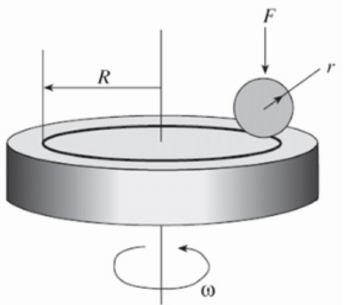
Figure 2. Tribological tests of samples according to the “ball-and-disk”